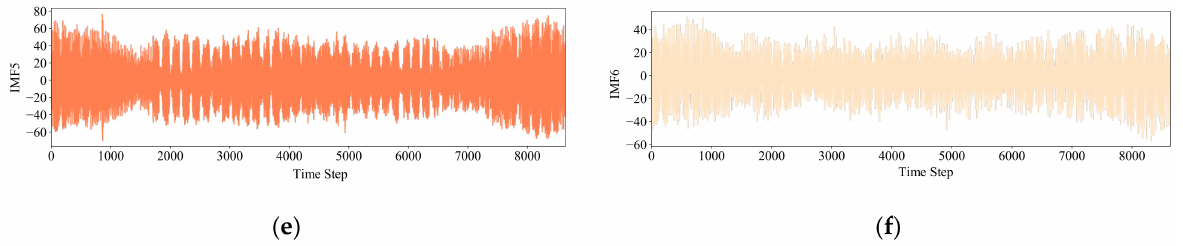
Figure 8. The decomposition results using the VMD algorithm. ( a ) IMF1; ( b ) IMF2; ( c ) IMF3; ( d ) IMF4; ( e ) IMF5; ( f )